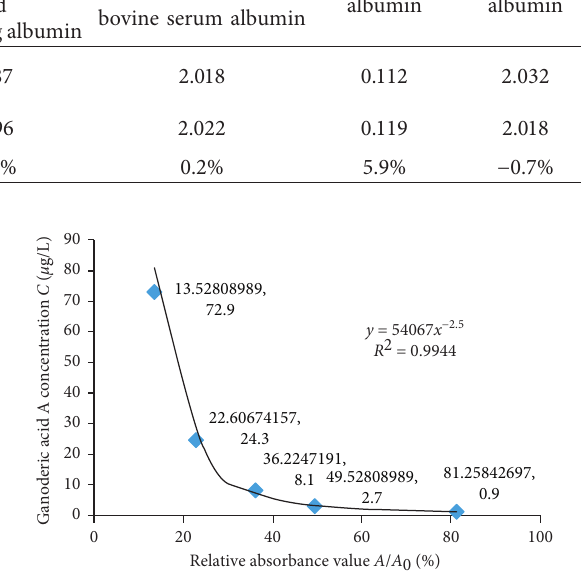
Figure 1: Regression curve of the relationship between relative absorbance and ganoderic acid A